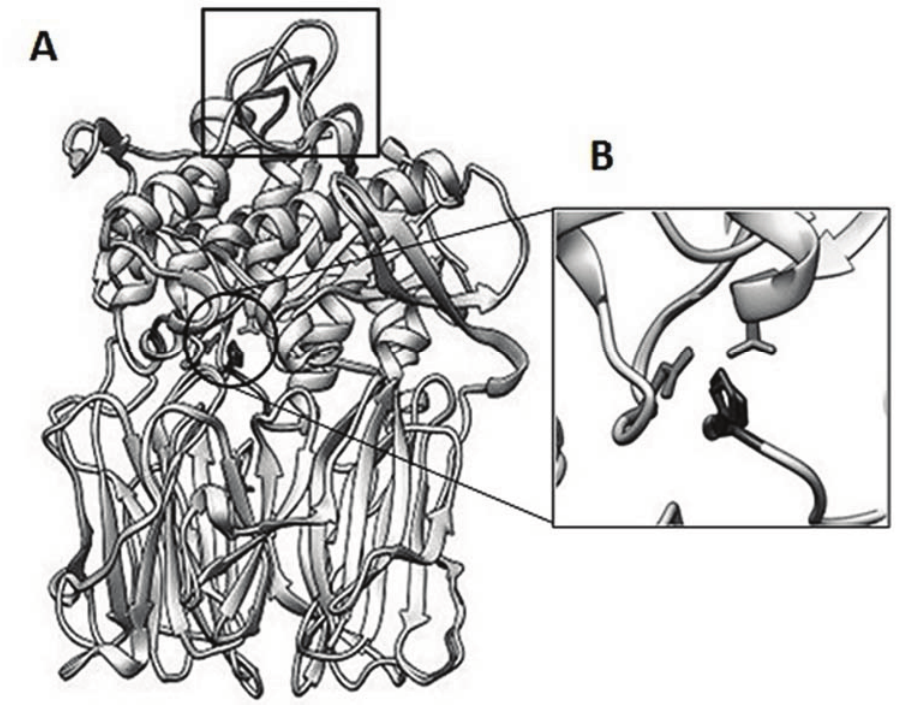
Figure 3. Homology model of the spPEP. SWISS-MODEL was used to fit the spPEP to a best fit to porcine PEP (2XDW.pdb). The Chimera 1.8.1 Match Align tool was used to generate the aligned structure ( A ). Differences between the structures are shown in solid black, which were identified using the structure assessment tool in Chimera. The boxed portion of the structure shows the highest deviation. The catalytic core residues are circled and align in close proximity to each other. The catalytic core residues are shown in an expanded view ( B